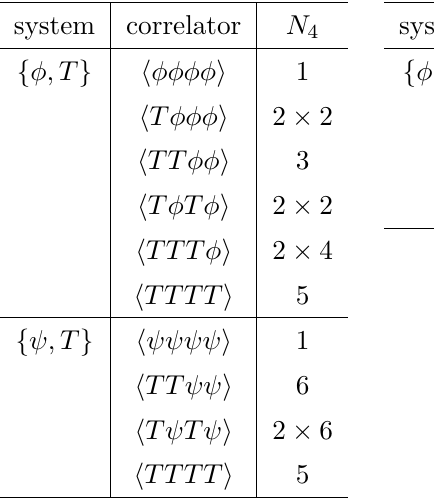
Table 2 : The systems of correlators that we consider in our performance comparison, along with the number of four-point structures N needed for each case. The notation 4 means that there are a different orderings of the operators (e.g. the orderings a × b for N 4 permutations, for the fixed OPE channel, and h T φT φ i and h T φφT i ), modulo Z × Z 2 2